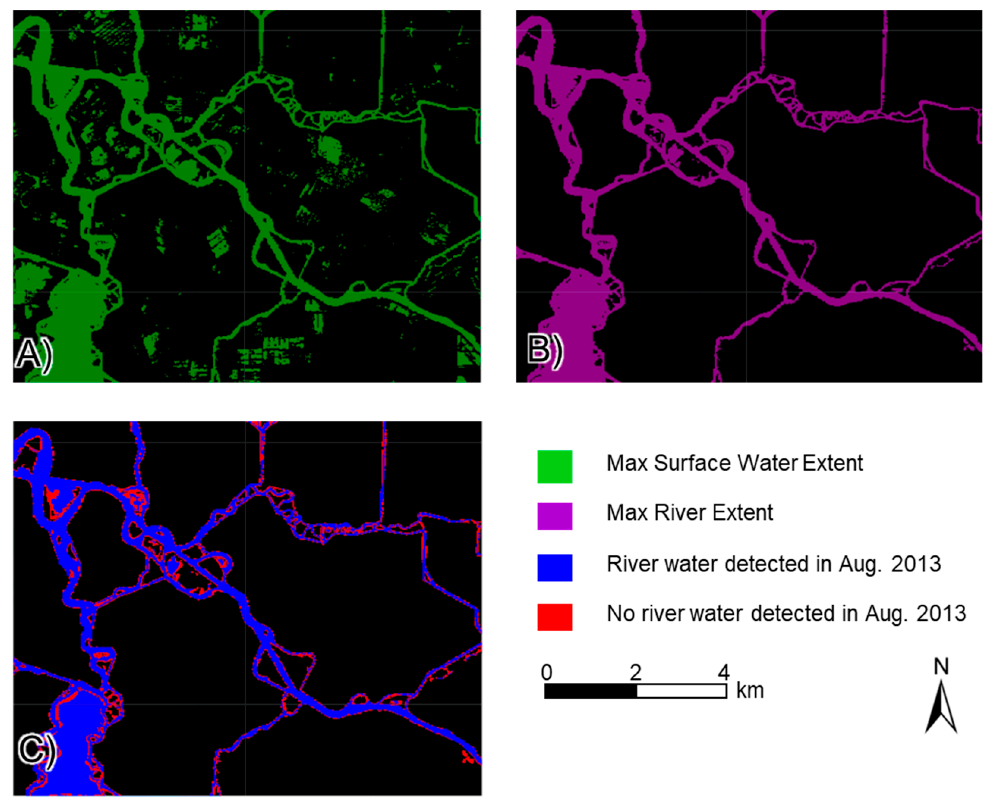
Figure 2. Examples of ( A ) maximum surface water extent (green) and ( B ) the maximum river extent (purple) extracted based on connectivity to river centerline, and ( C ) the water and no-water pixels in the GSW monthly water history product masked by the maximum river extent in August of 2005. The location is near 38°N and 121.5°W.